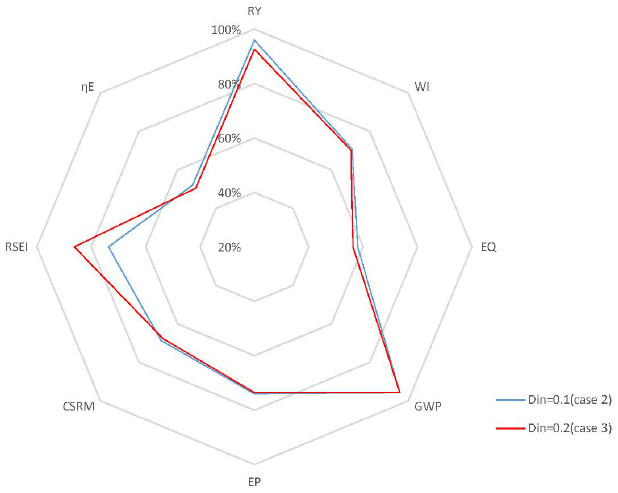
Figure 11. Radar plot with GREENSCOPE indicators for closed-loop simulations with different D in (Case 3).